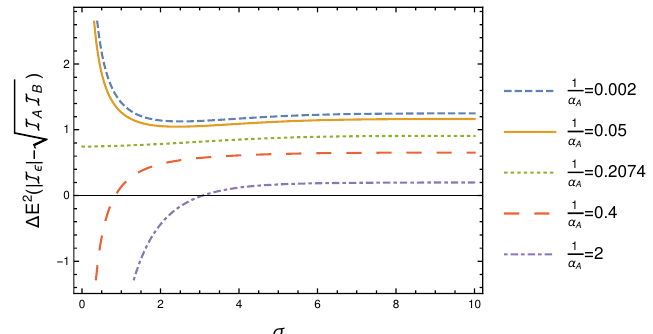
√ (cid:0) (cid:1) is plotted for two anti-parallelly |I ε | − I A I B